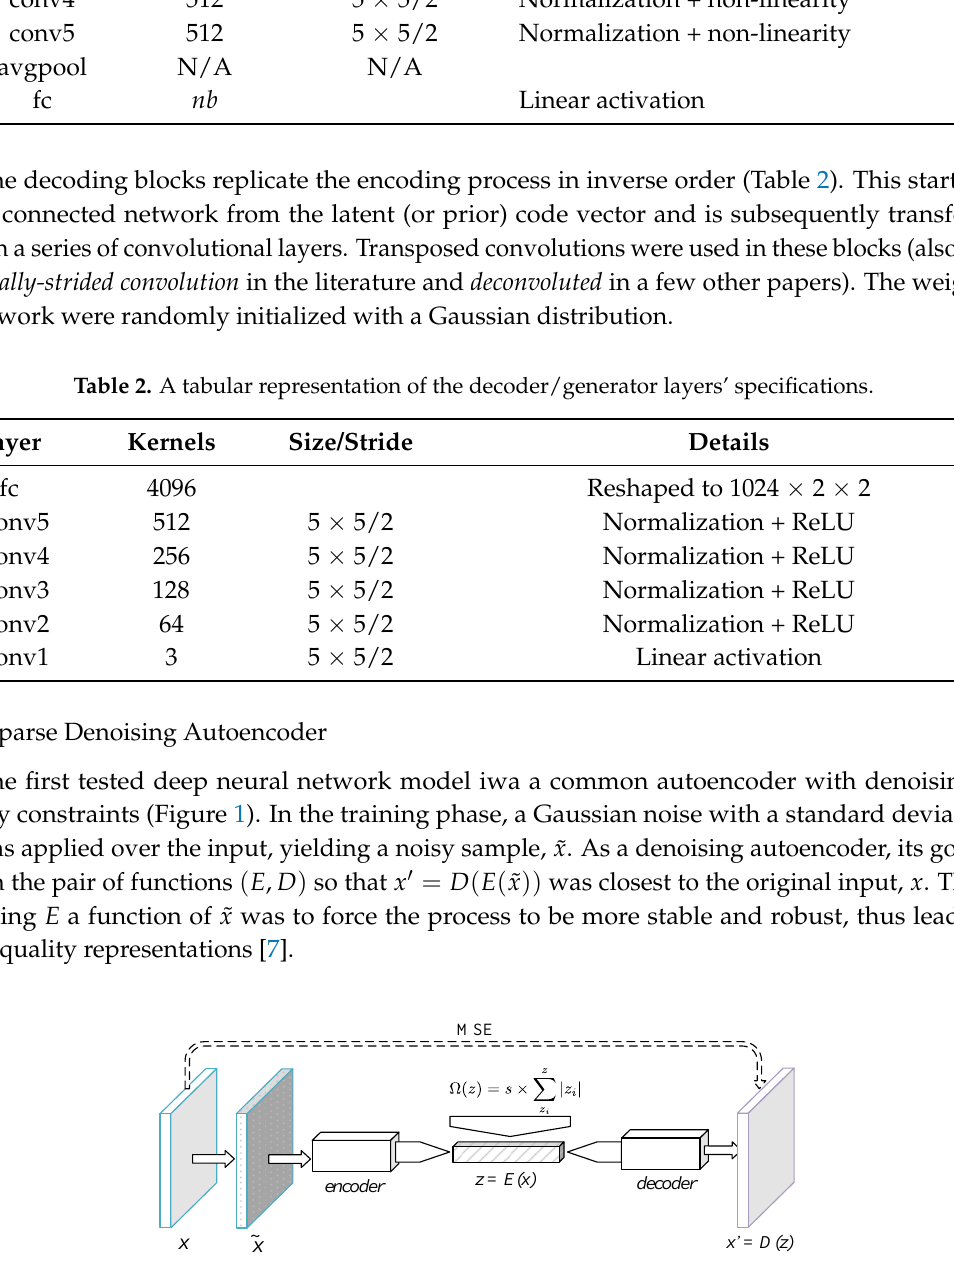
Figure 1. Diagram of the sparse denoising